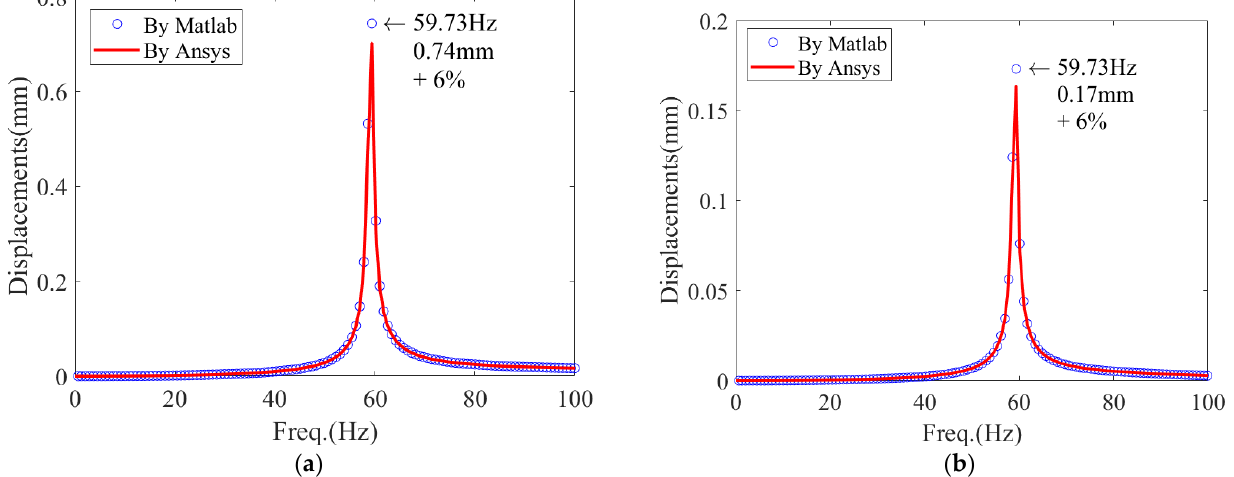
Figure 20. Comparison of the results obtained by Ansys and Matlab: ( a ) response of the disk; ( b ) response of the 3# bearing-support.